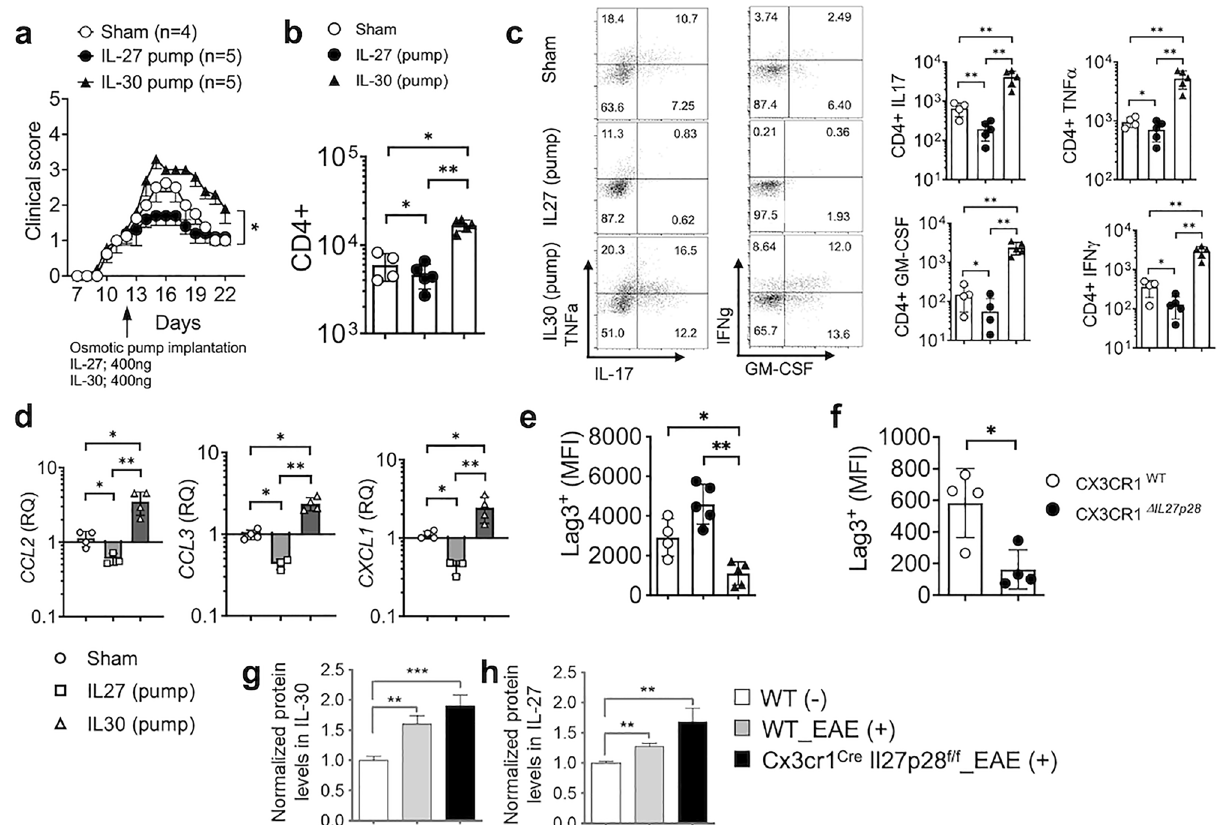
Figure 5. In vivo IL-30 administration develops significantly exacerbated EAE. C57BL/6 mice were induced for EAE. Osmotic pumps containing IL-27 (400 ng, n = 5), IL-30 (400 ng, n = 5) were subcutaneously implanted or sham surgery (n = 4) was performed at 12 days post induction. ( a ) EAE score. ( b ) Total CD4 + T cell numbers in the CNS at 22 days post induction. ( c ) The numbers of GM-CSF, IFNγ, IL-17, and TNFα + CD4 T cells were determined by intracellular cytokine staining at day 22 post immunization. ( d ) qPCR analysis of the indicated chemokine expression in the brain from the sham, IL-27-pump and IL-30-pump group. Gene expression was normalized by Gapdh and compared to that of sham surgery group. ( e ) Lag3 expression of CNS infiltrating Treg cells was determined by flow cytometry. ( f ) Cx3cr1 WT and Cx3cr1 Δ Il27p28 mice induced for EAE as described in Fig. 4 were used to measure CNS infiltrating Treg cell expression of Lag3. ( g , h ) IL-30 and IL-27 levels in the CNS homogenates were measured by ELISA and were normalized to those of naïve wild type mice. n = 7 per group. *p < 0.05; **p < 0.01; ***p < 0.001; as determined by Mann–Whitney nonparametric